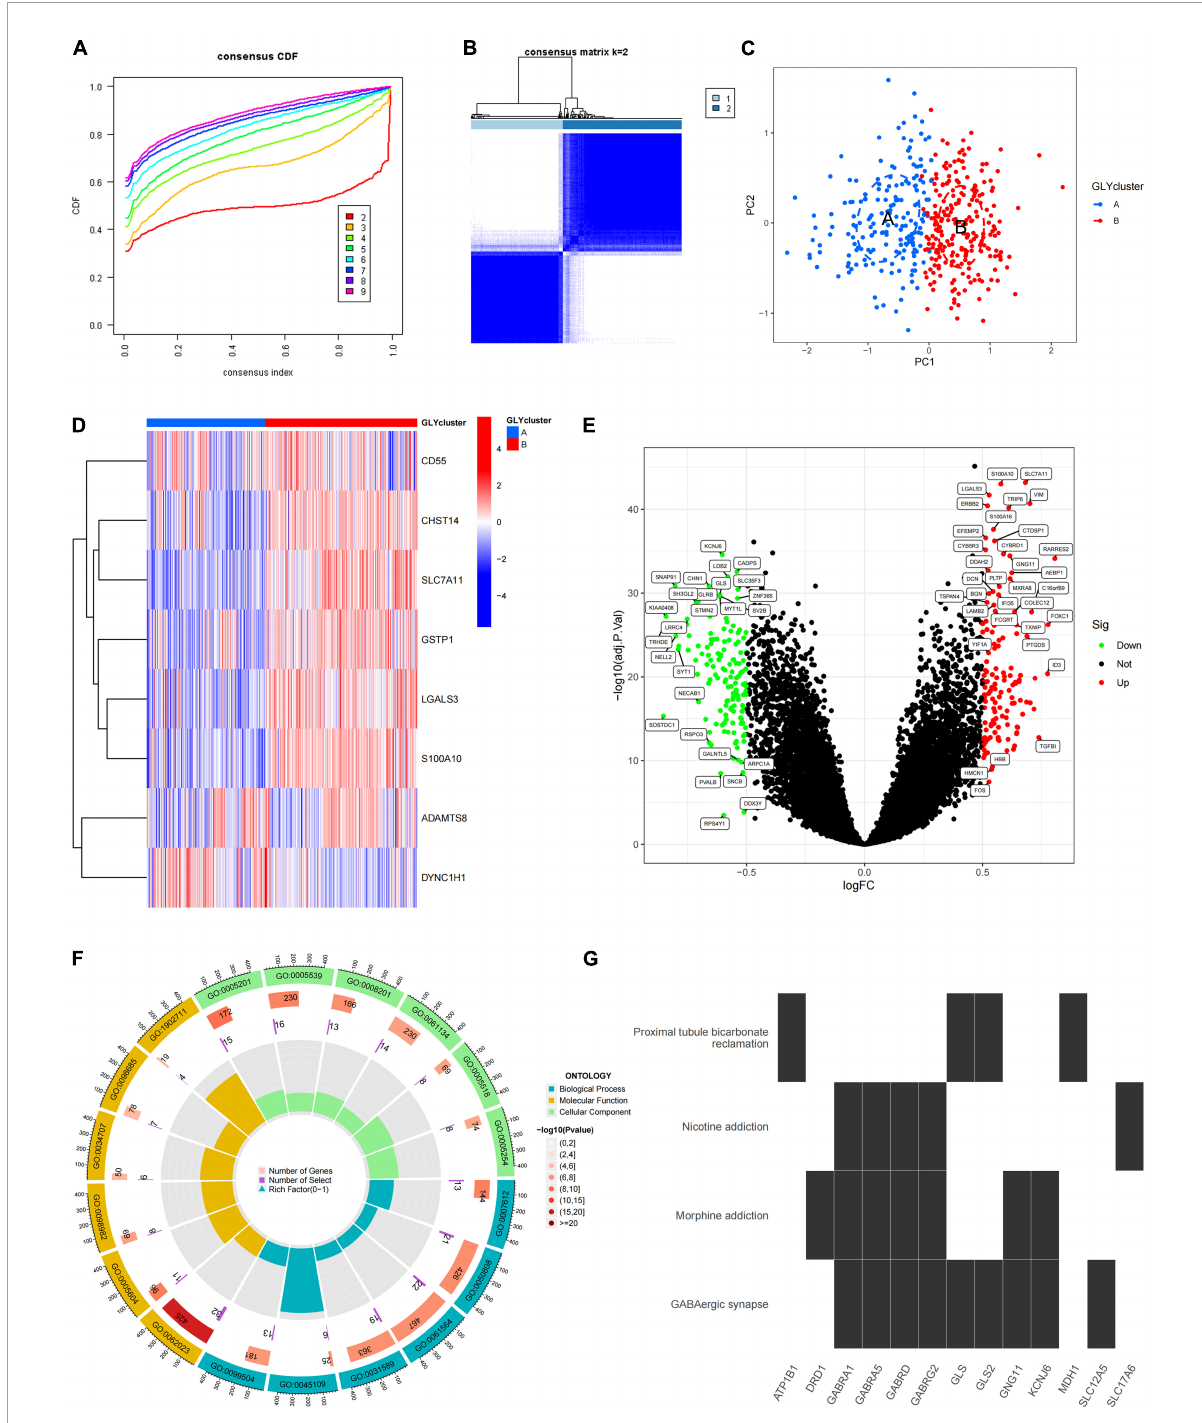
FIGURE2 The two distinct protein glycosylation-related subtypes in Alzheimer’s disease (AD) identified by unsupervised clustering of eight protein glycosylation-related genes (PGRGs). (A) Consensus clustering cumulative distribution function (CDF) for k = 2–9. (B) Heatmap of the matrix of co-occurrence proportions of AD samples. (C) Principal component analysis (PCA) is used to determine the discrimination of A and B subtypes. (D) The difference in the expression of eight core PGRGs between the two subtypes. (E) Differentially expressed genes between the subtypes. (F) GO analysis of differentially expressed genes between the subtypes reveals related biological processes, molecular functions, and cellular components. (G) Kyoto Encyclopedia of Genes and Genomes (KEGG) enrichment analysis of differentially expressed genes between the